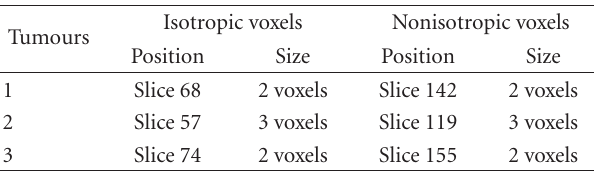
Table 2: Tumours characteristics for the second data set with 2 types of